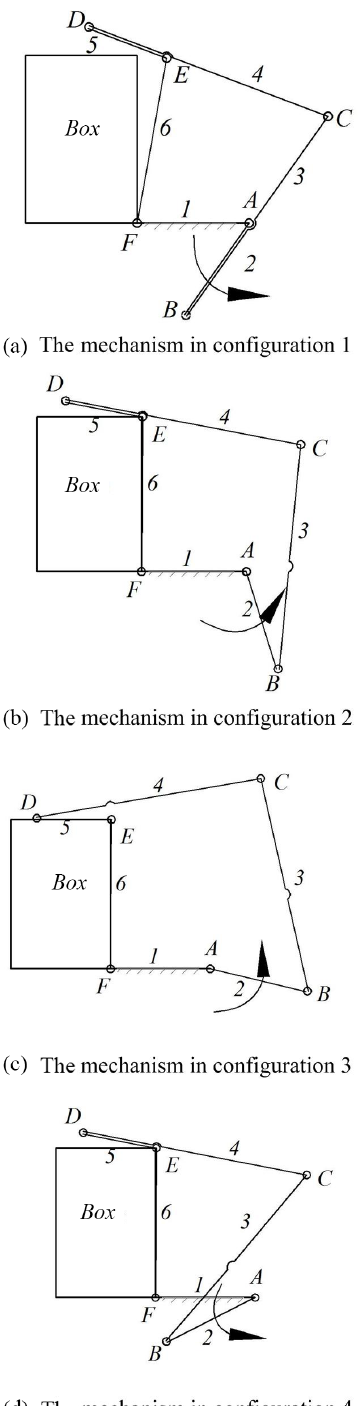
Figure 5. A planar 3- RRR parallel